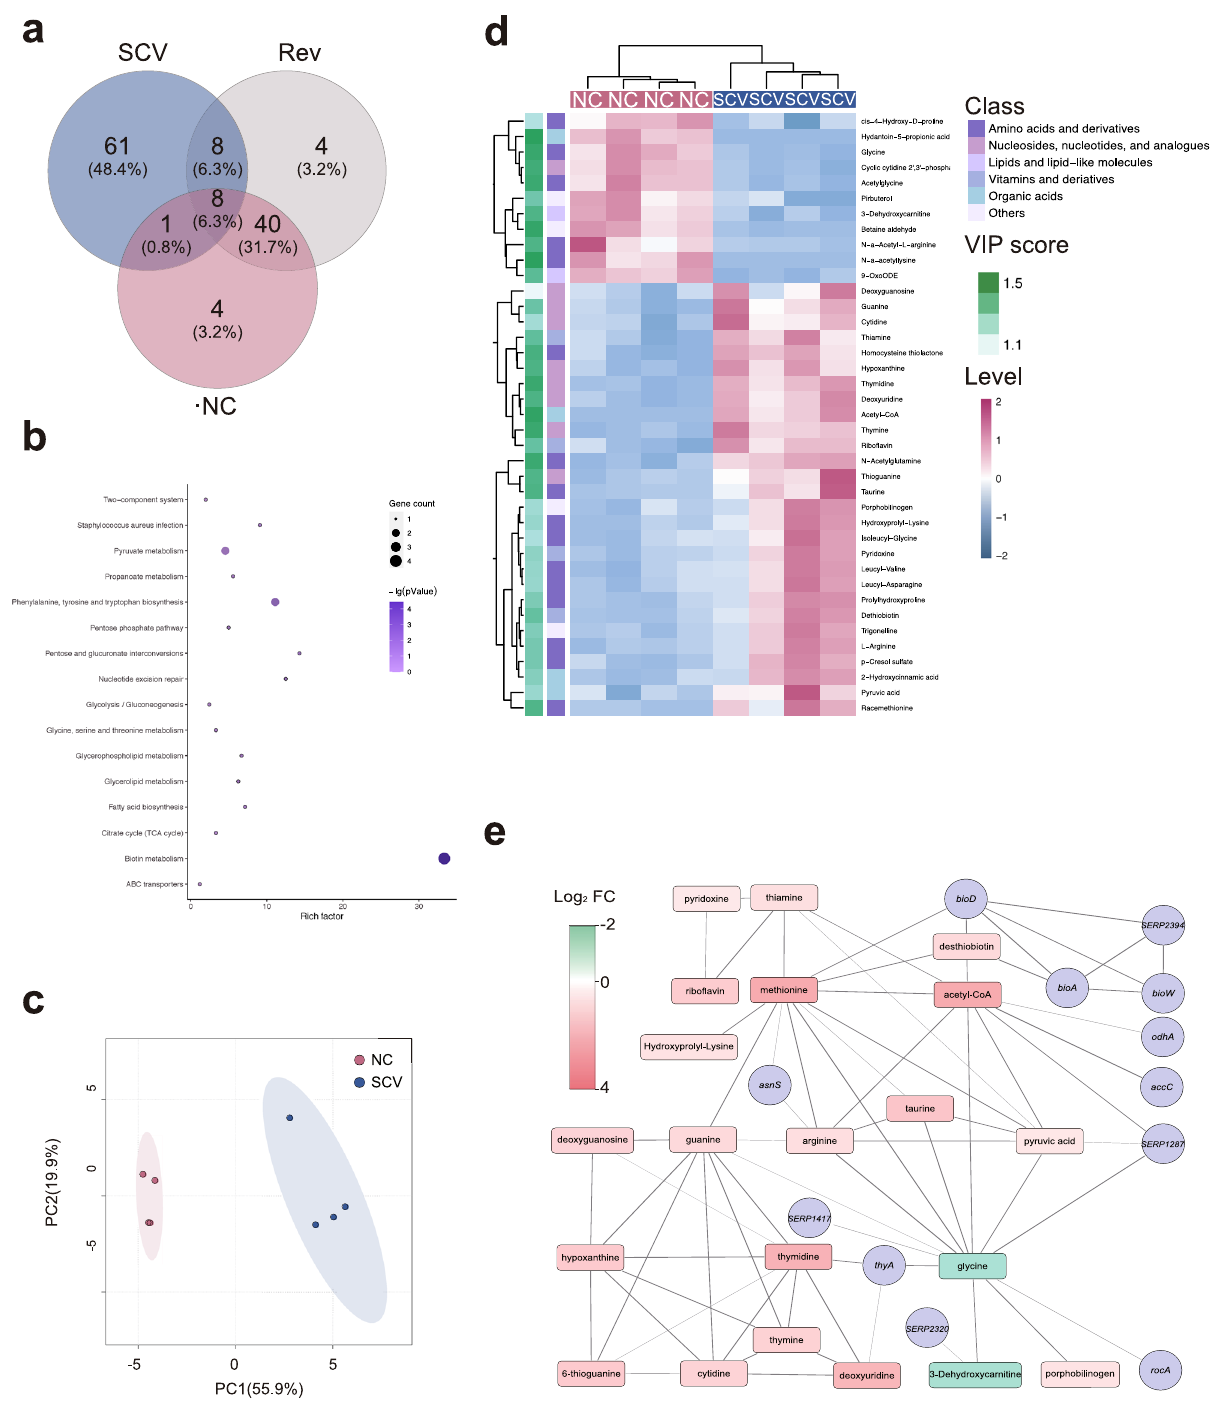
Fig. 3 Genomic mutation-based analyses and metabolomics analyses of S. epidermidis stable SCV. a Venn diagram showing numbers of SNV-containing genes overlapping between and shared by indicated isolates. b The Kyoto Encyclopedia of Genes and Genomes (KEGG) pathways enrichment for the mutation-related gene set. c Principal component analyses (PCA) based on the entire primary metabolome set. Each biological replicate is colored by group and displayed as dot. Contribution of each principal component to the total variance is given in the parenthesis as percentage. d A hierarchical clustering heat map illustrating normalized abundance (green lower, violet red higher), superclass, and VIP score of differentially expressed metabolites (DEMs). Each column denotes one of the biological replicates of indicated group. e The association network linking DEMs and mutant genes. Genes and metabolites are, respectively, shown as circles and rounded rectangles colored according to Log 2 fold change (red higher, green lower). Line thickness denotes the con fi dence score for the link between indicated nodes (the thicker, the higher) and only high-scoring links are shown (cutoff = 0.7).